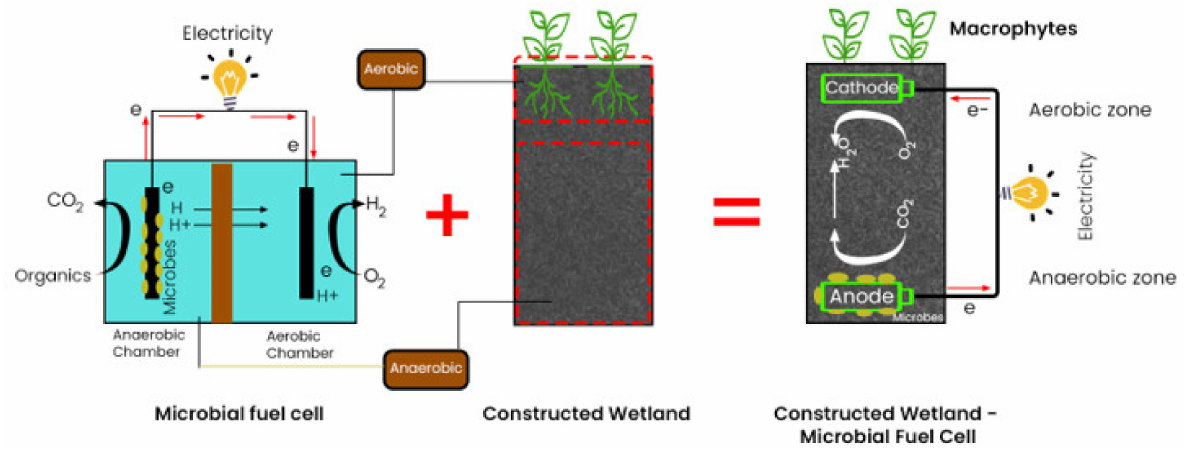
Figure 1. A graphical illustration of constructed wetland coupled